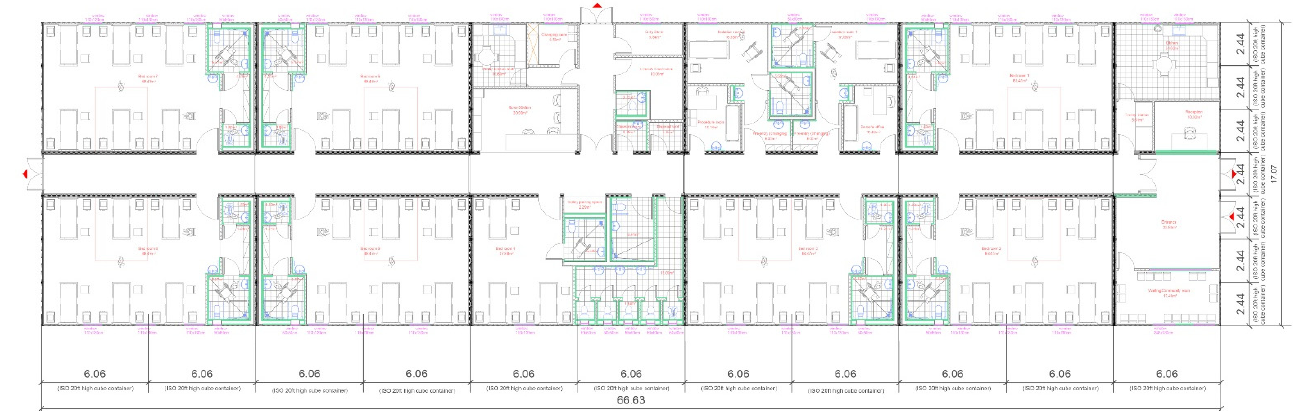
Figure A8. Laboratory department plan of the relocatable hospital in Mosul.